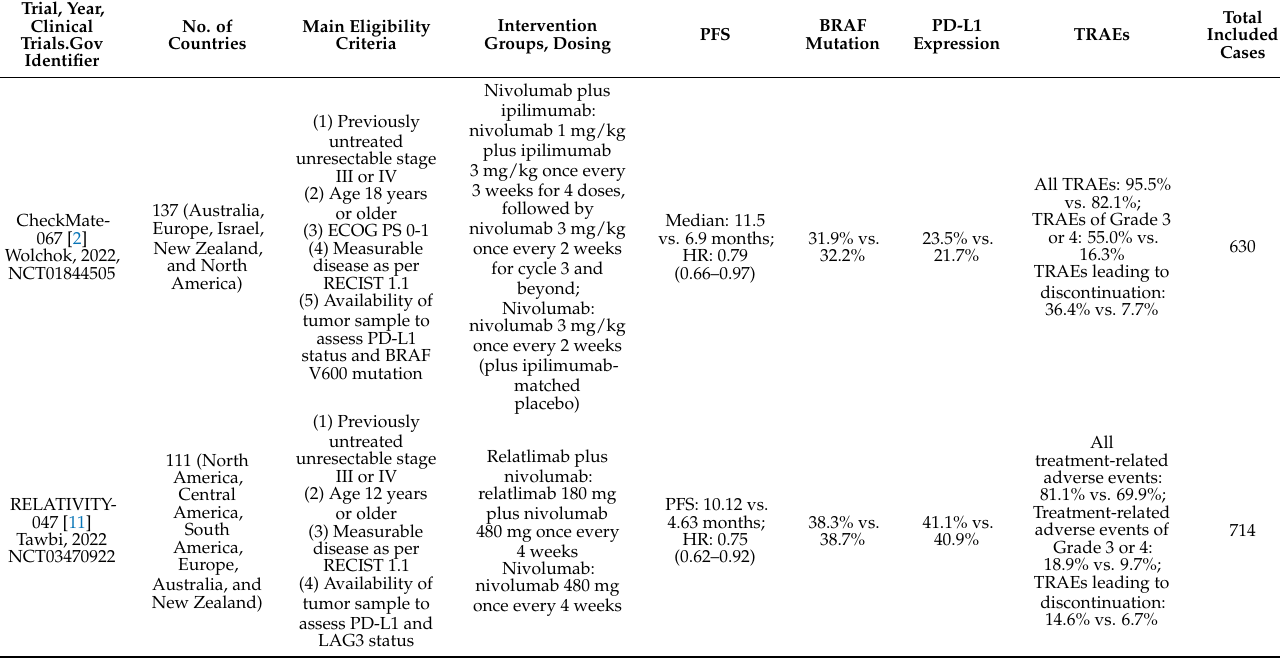
Table 1. Study Information and Characteristic of Trials.